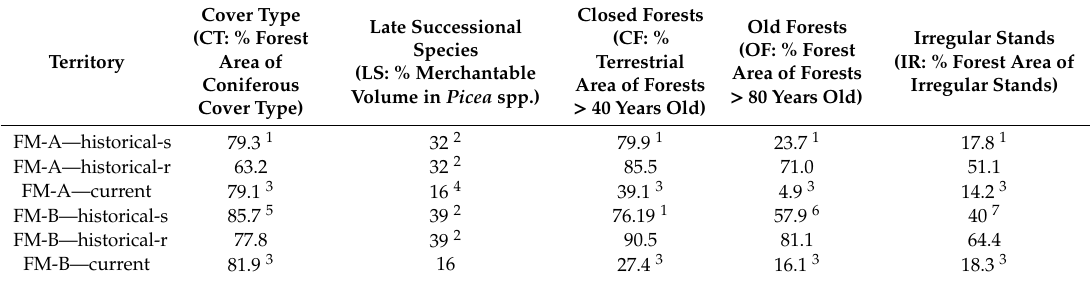
Table A1. Historical values from studies (s) in Forest Montmorency vicinity or reference state registry (r) used as reference data, and current values from 2018 eco-forest